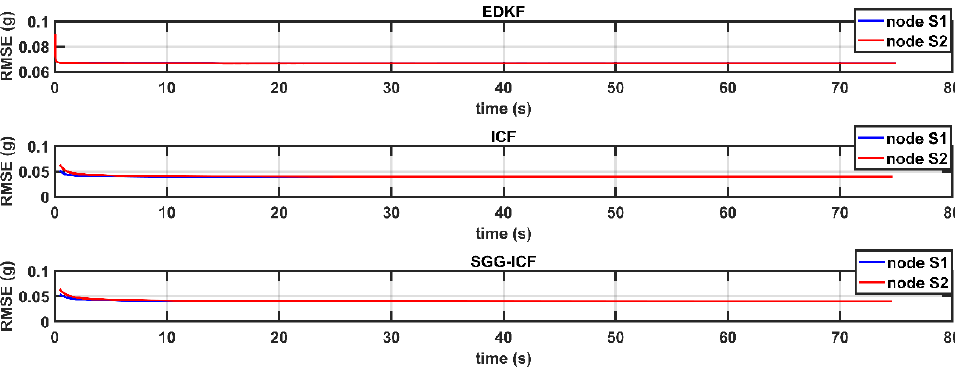
Figure 9. RMSE of the selected DKF algorithms.